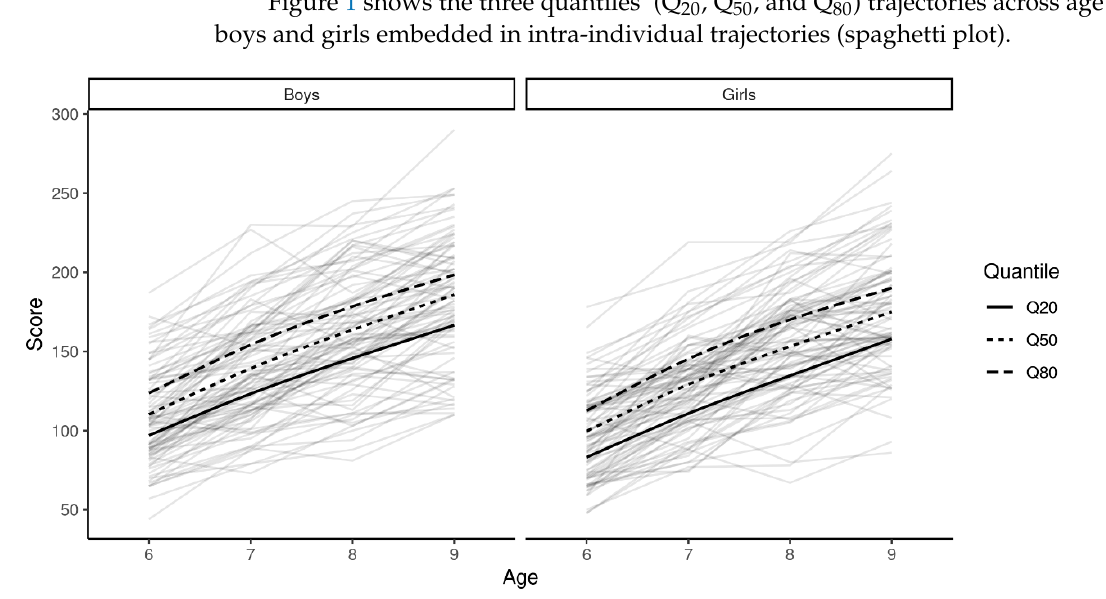
Figure 1. Modeled trajectories of the three percentiles, Q 20 , Q 50 , and Q 80 , in boys and girls.